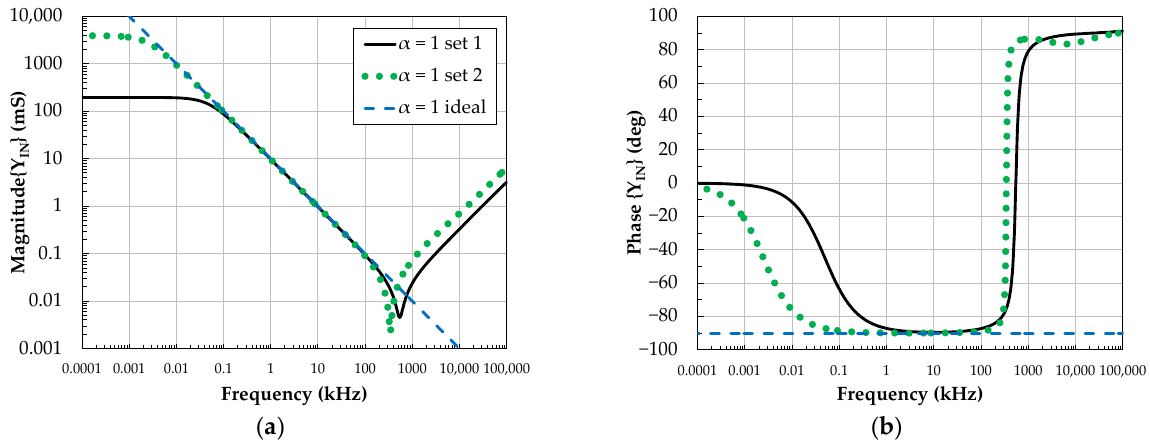
Figure 13. Simulated magnitude ( a ) and phase ( b ) characteristics of gyrator input admittance for α = 1.